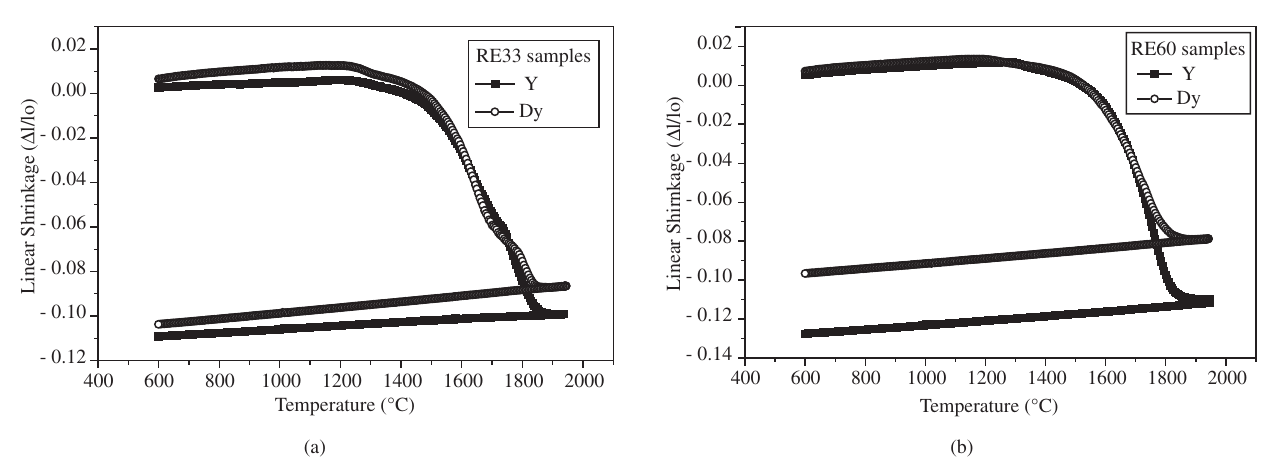
Figure 5. Dilatometric results: linear shrinkage versus temperature for several compositions: a) RE 33 samples (RE = Y, Dy); b) RE 60 samples (RE = Y, Dy).